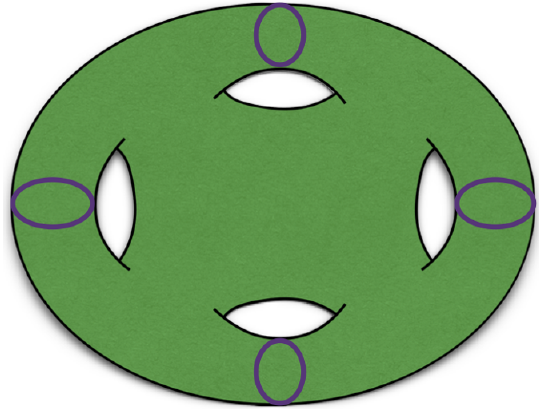
Figure 4 . The naive handlebody phase for a genus 4 boundary with the (cid:11) cycles drawn in purple. The four (cid:12) cycles are not drawn but each circle one of the four